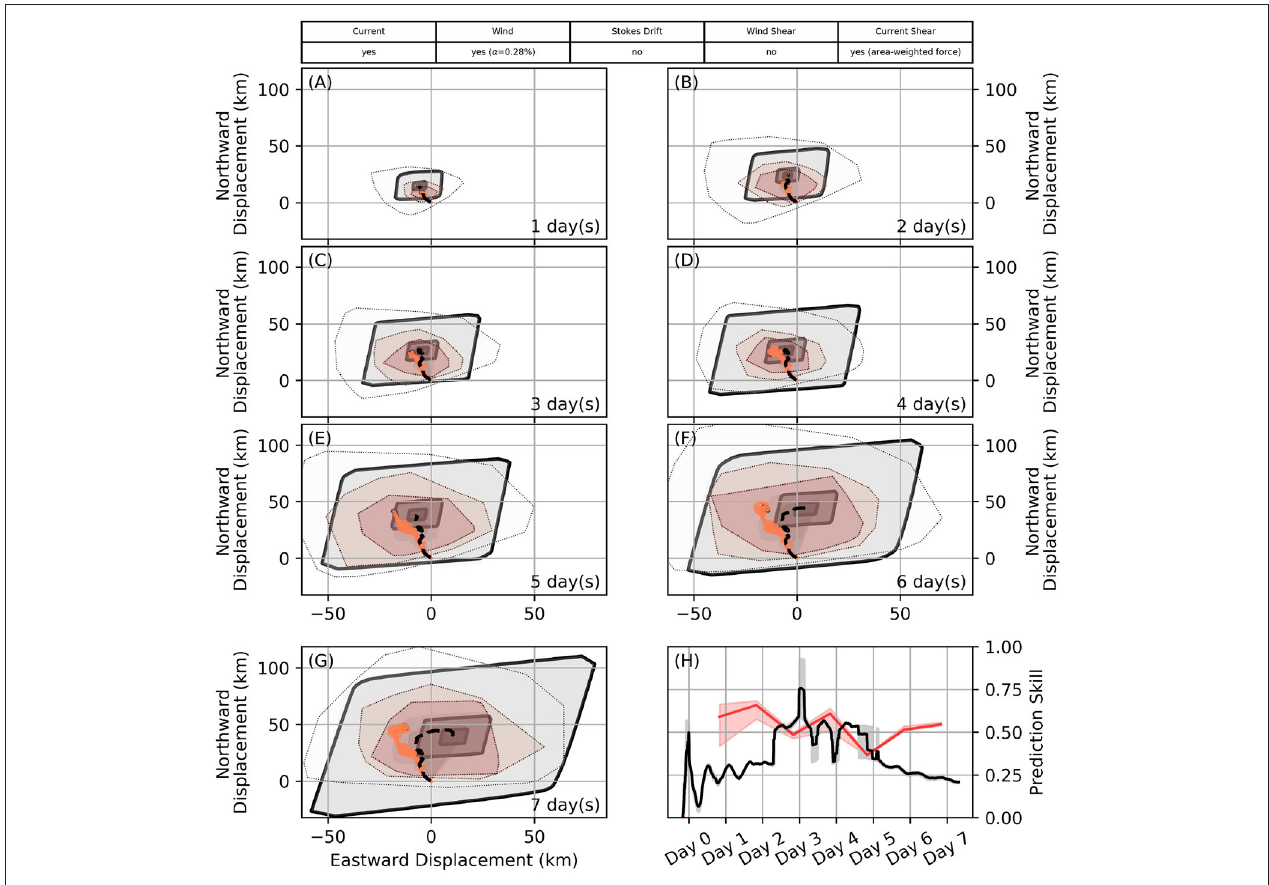
FIGURE 12 | Daily predicted tracks of the SVP 8 drifters for 7 days after deployment using the indicated optimal forcing combination (A–G) , and a time series of model skill during this period (H) . Same layout as Figure 9 .